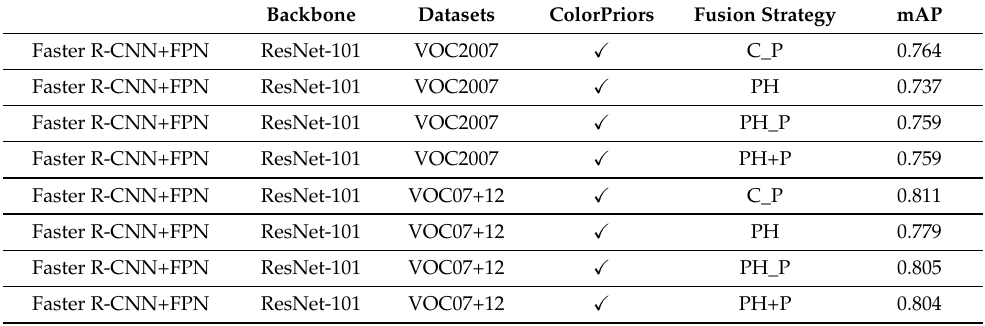
Table 5. Performance comparison of object detection algorithms using different feature fusion strategies.